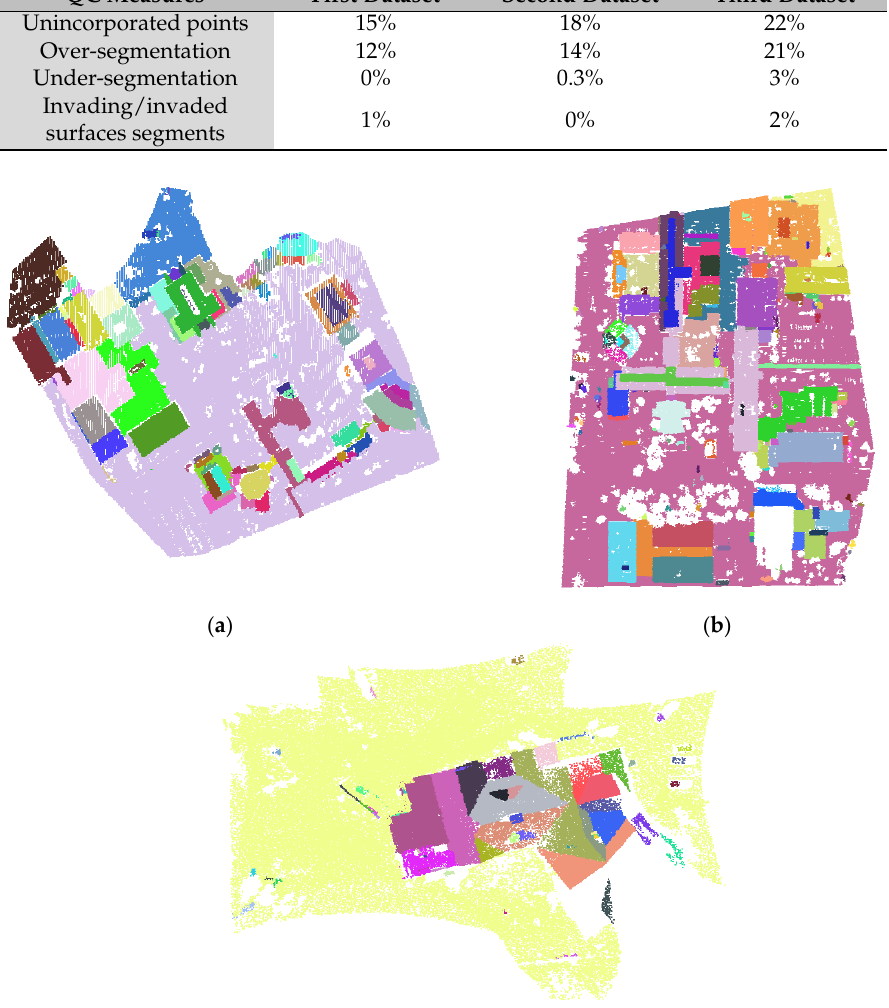
Figure 28. Planar surface extraction results for the ( a ) first; ( b ) second; and ( c ) third laser scanning datasets after quality control